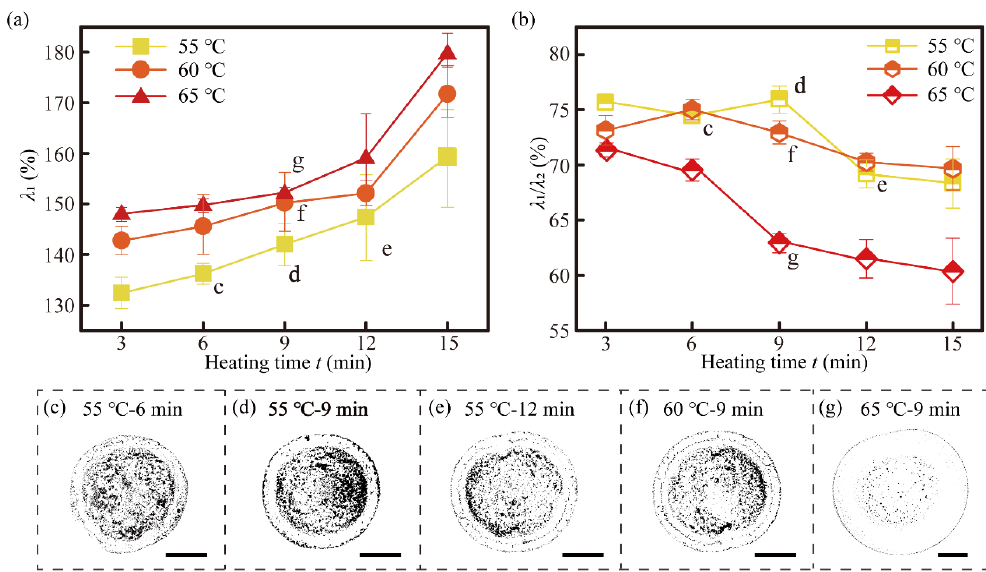
Figure 6. Effects of the films with different heating temperatures and times on the droplet spreading processes and the final morphologies. ( a ) Effect of the heating temperature and time of the films on the droplet spreading ratio λ 1 . ( b ) Effect of the pre-processing temperature and time of films on the droplet ring – ridge ratio λ 1 / λ 2 . ( c – g ) Optical microscope images of the CNT droplet deposition patterns on PVA films that were preprocessed under different heat treatment conditions. All scale bars are 80 μm in ( c – g ).